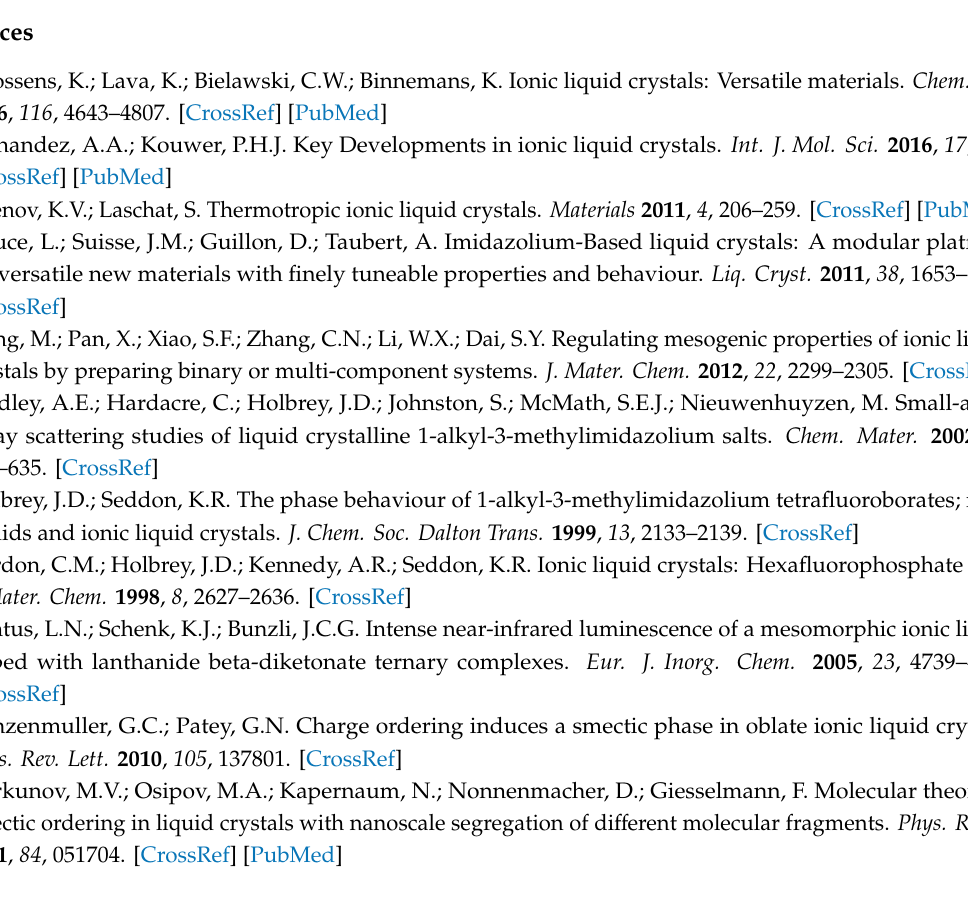
Table S1: Ionic liquid crystals samples C 12 mimX data, Figure S1: PDLF pulse sequence to record dipolar 13 C- 1 H spectra, Figure S2: 1D 13 C CP NMR spectra in smectic phase of C 12 mimCl, C 12 mimBr, C 12 mimI, and C 12 mimBF 4